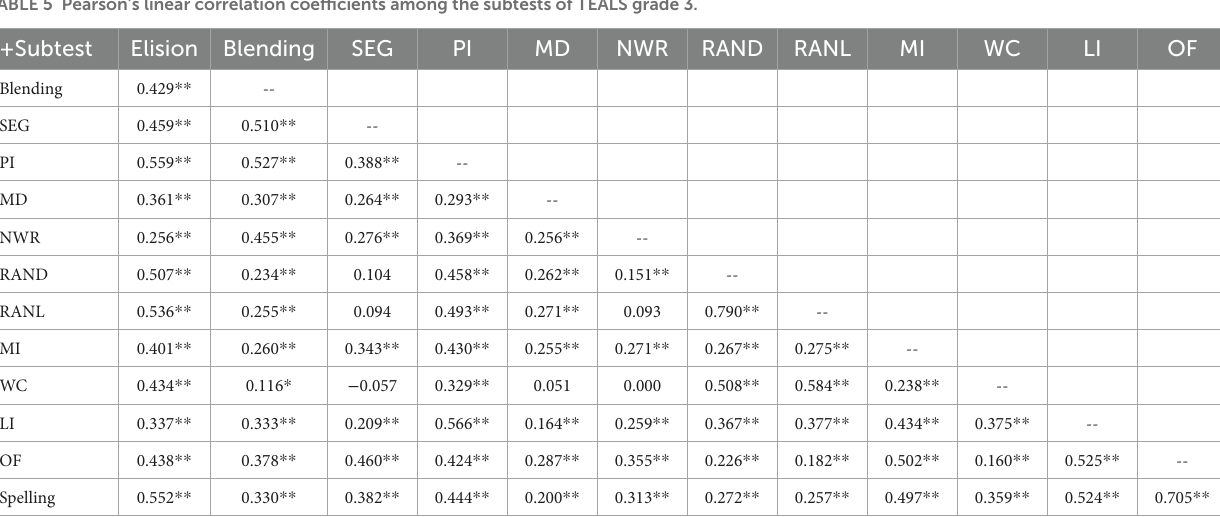
TABLE 5 Pearson’s linear correlation coefficients among the subtests of TEALS grade